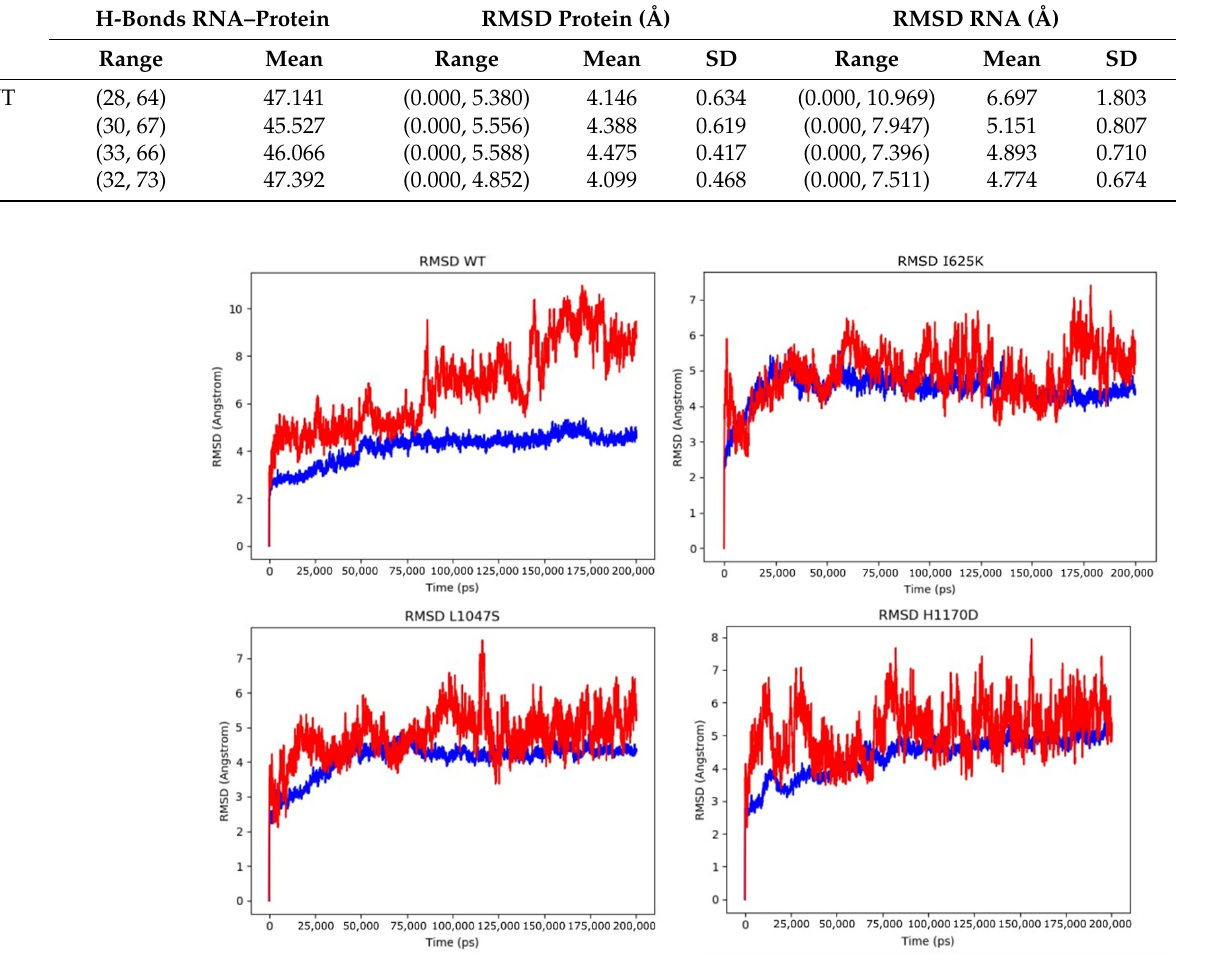
Figure 4. Results of 200 ns MD simulations of DROSHA wild-type protein along with its mutants (I625K, L1047S, H1170D) in a complex with miRNA. The RMSD plot for protein structure is colored blue, and RMSD fluctuations of miRNA are indicated by red. Table 4. Statistics of energy values of DROSHA complex with RNA. Minimal total energy and mean total energy values are presented. Binding energy ( ∆ G Bind) between protein and RNA was calculated by the MM-GBSA method.